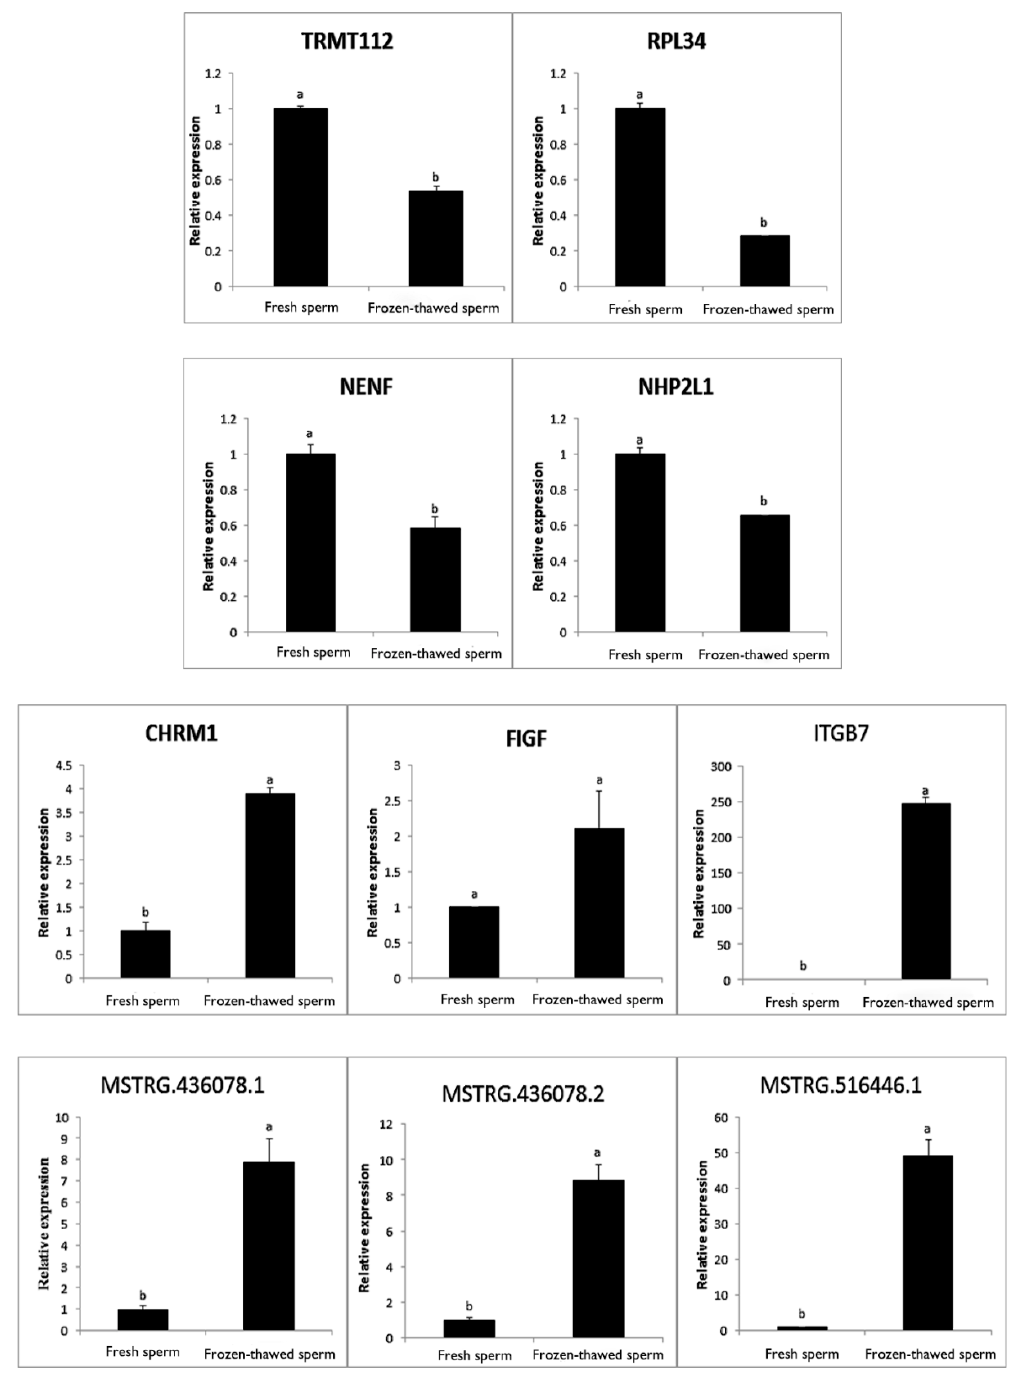
Figure 5. Validation of transcript expression by qRT-PCR. Glyceraldehyde-3-phosphate dehydrogenase (GAPDH) gene was used as a housekeeping internal control. Transcript expression was quantified relative to the expression level of GAPDH using the comparative cycle threshold (2 − ∆∆ C t ) method. Different letter indicates p < 0.05.